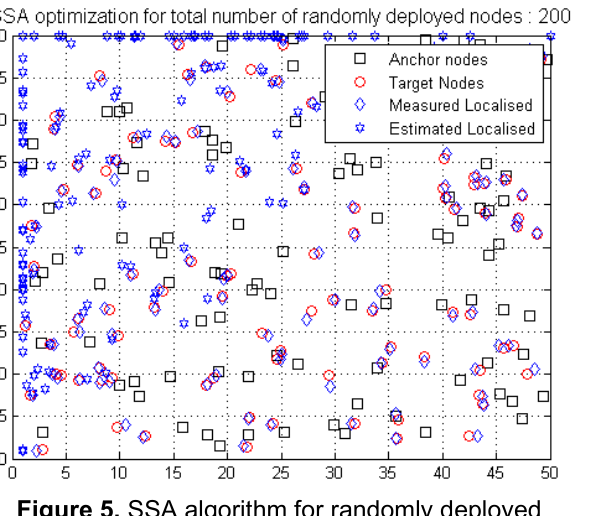
Figure 5. SSA algorithm for randomly deployed sensor nodes located in the target area